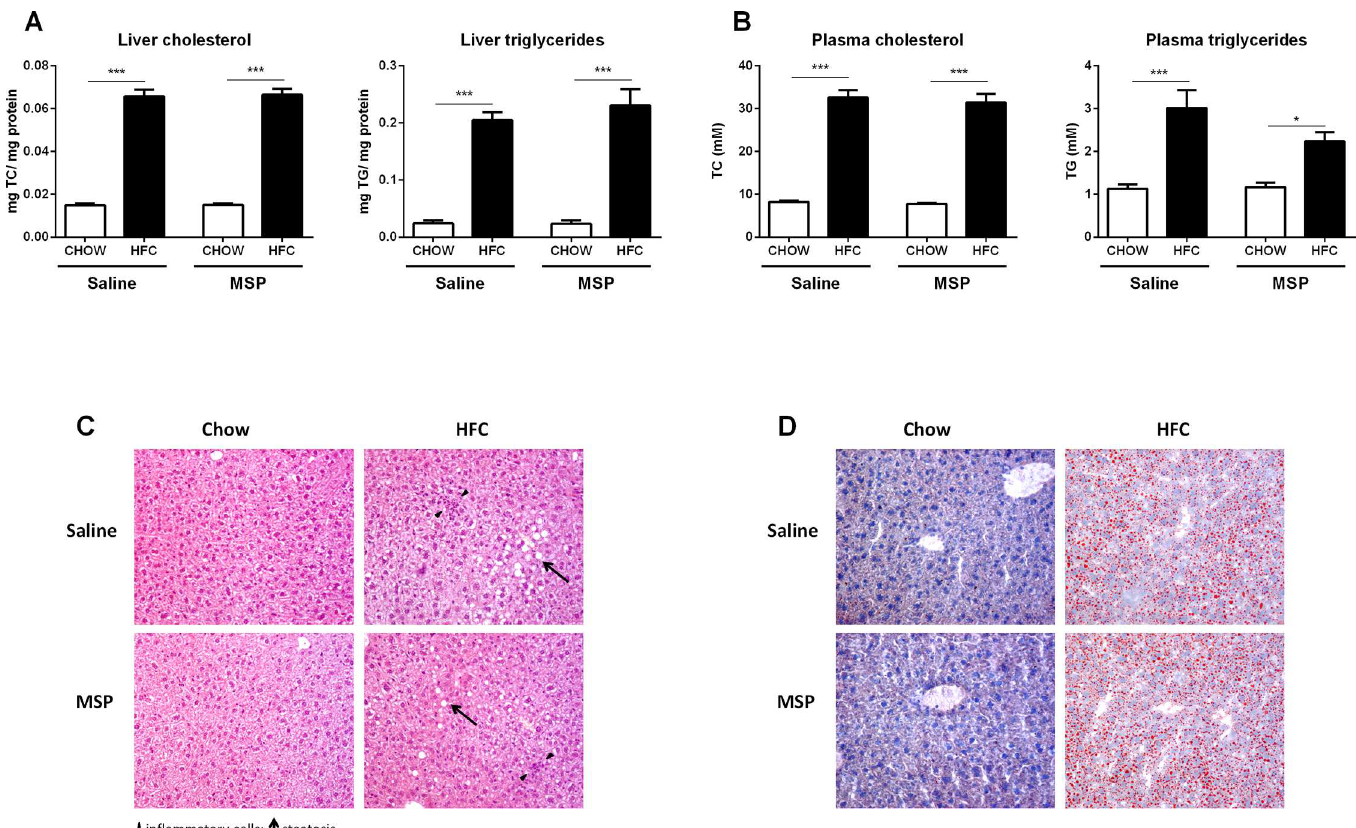
Fig 2. Liver and plasma lipid levels. (A) Hepatic levels of total cholesterol (TC) and total triglycerides (TG) after one week of regular chow or HFC diet in Ldlr -/- mice, with and without MSP treatment. (B) Plasma TC and TG levels. (C,D) Representative images (200x magnification) of the H&E staining and Oil Red O staining of liver sections. Data are representedas mean ± SEM. * and *** indicate significant differences between groups, with * p (cid:20) 0.05 and *** p < 0.001.